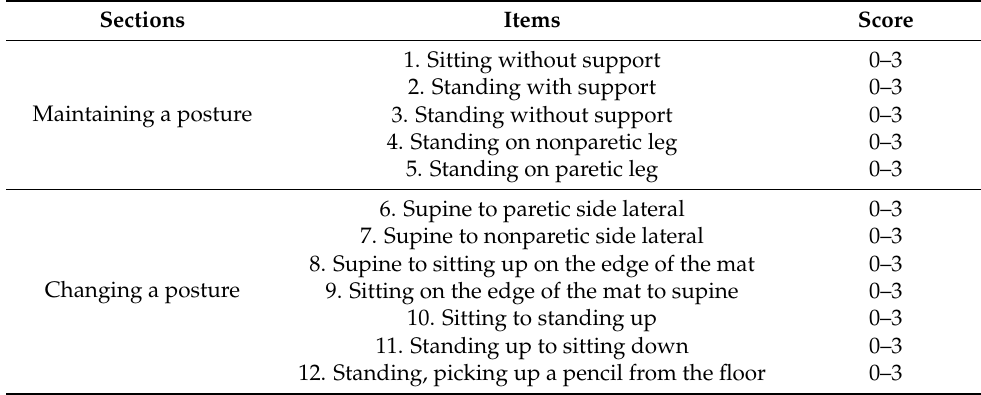
Table 1. Sections and items assessed in the Postural Assessment Scale for post-stroke